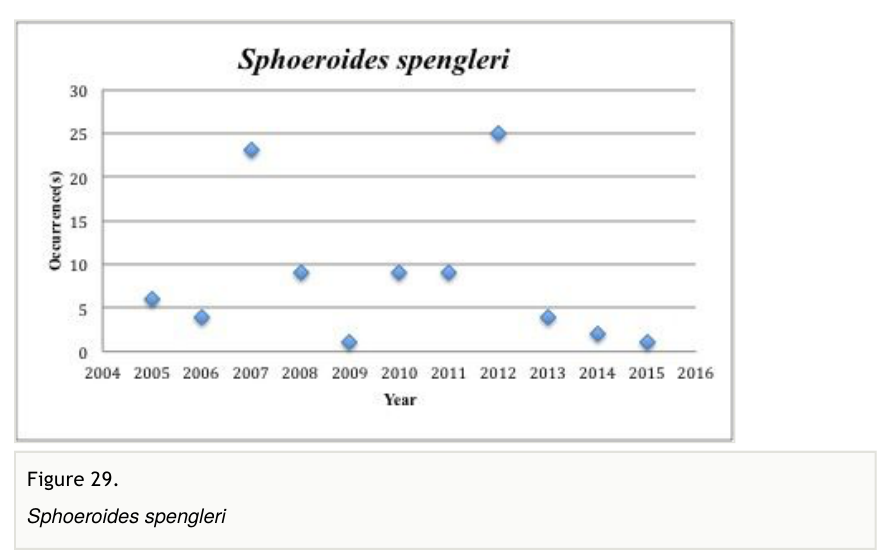
Figure 29. Sphoeroides